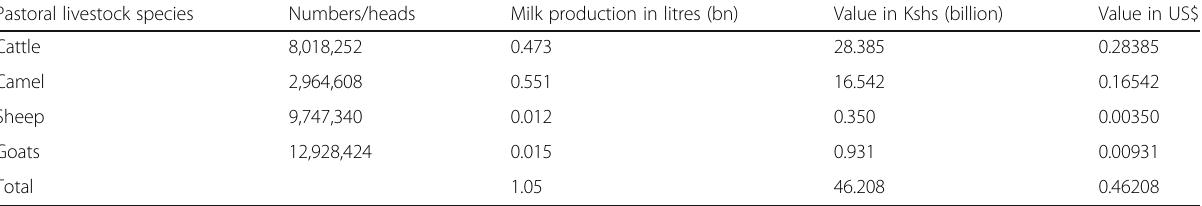
Table 5 Average amount (litres) and value (Kshs and US$) of pastoral milk offtake in Kenya for the period 2010 to 2015; 1US$ is equivalent to Kshs